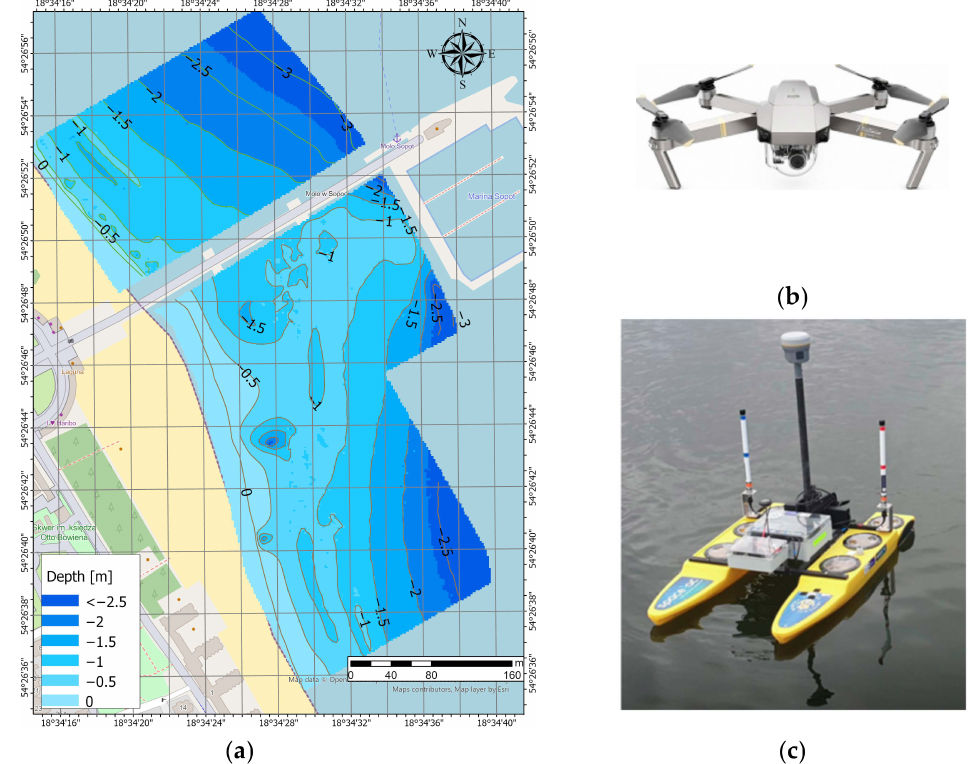
Figure 3. A bathymetric chart of the waterbody adjacent to the Sopot pier, developed based on hydrographic and photogrammetric surveys carried out in 2019 ( a ), and the measurement equipment used during the survey: a DJI Mavic 2 Pro UAV ( b ) and Seafloor Systems Hydrone USV ( c